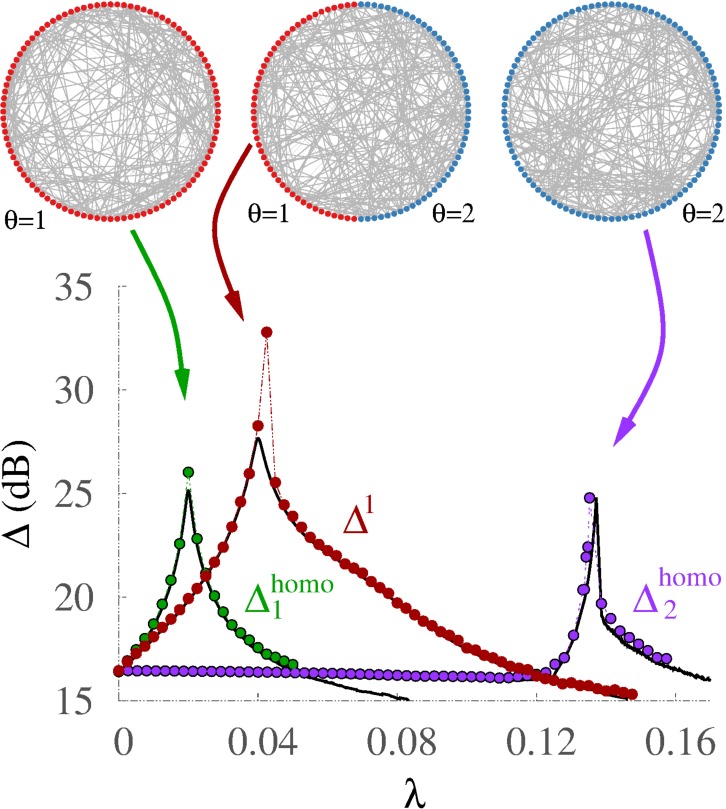
Threshold diversity improves performance.Comparison of dynamic ranges for homogeneous networks where all units have threshold θ = 1 (green, \documentclass[12pt]{minimal}
\usepackage{amsmath}
\usepackage{wasysym}
\usepackage{amsfonts}
\usepackage{amssymb}
\usepackage{amsbsy}
\usepackage{upgreek}
\usepackage{mathrsfs}
\setlength{\oddsidemargin}{-69pt}
\begin{document}
}{}${\Delta }_{1}^{\mathrm{homo}}$\end{document}Δ1homo) or θ = 2 (purple, \documentclass[12pt]{minimal}
\usepackage{amsmath}
\usepackage{wasysym}
\usepackage{amsfonts}
\usepackage{amssymb}
\usepackage{amsbsy}
\usepackage{upgreek}
\usepackage{mathrsfs}
\setlength{\oddsidemargin}{-69pt}
\begin{document}
}{}${\Delta }_{2}^{\mathrm{homo}}$\end{document}Δ2homo) with the θ = 1 subpopulation of the bimodal distribution (red, Δ1). Solid black lines correspond to the mean-field approximation (see ‘Methods’), dotted lines join the numerical data points.